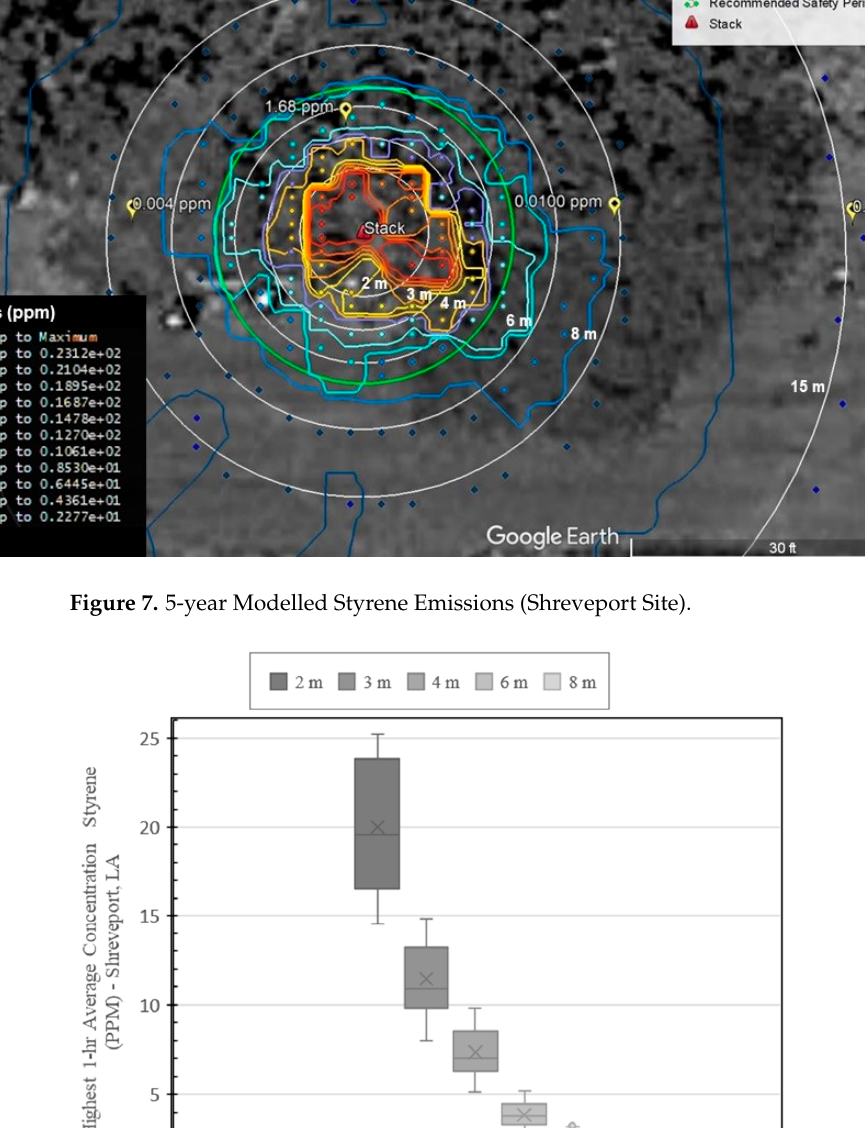
Figure 8. 5-year Modeled Styrene Concentrations by Radial Distance (Shreveport Site).